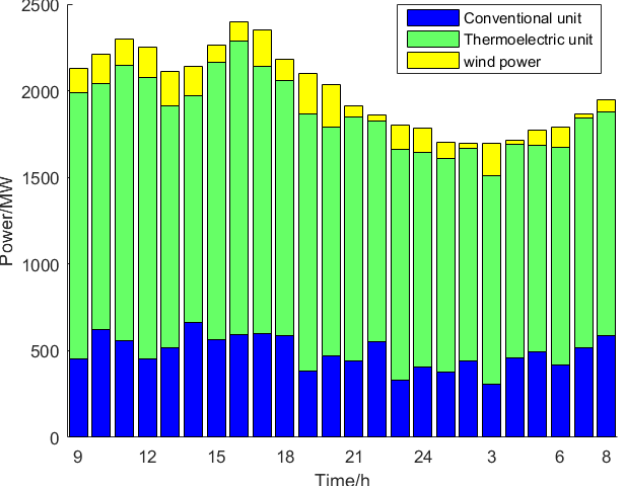
Figure 15. Unit output in no-heat storage mode.